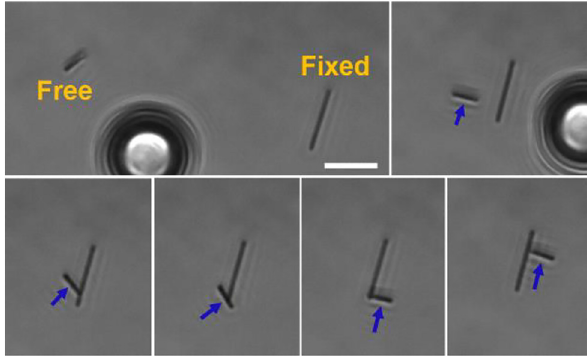
Figure 5: A swallow-tail nanostructure assembled with two Ag nanowires. The scale bar is 10 μ